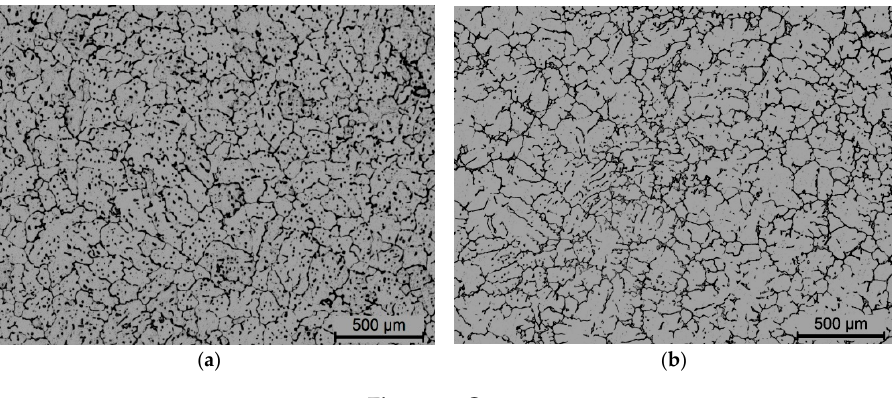
Table 1. Chemical compositions of experimental alloys,